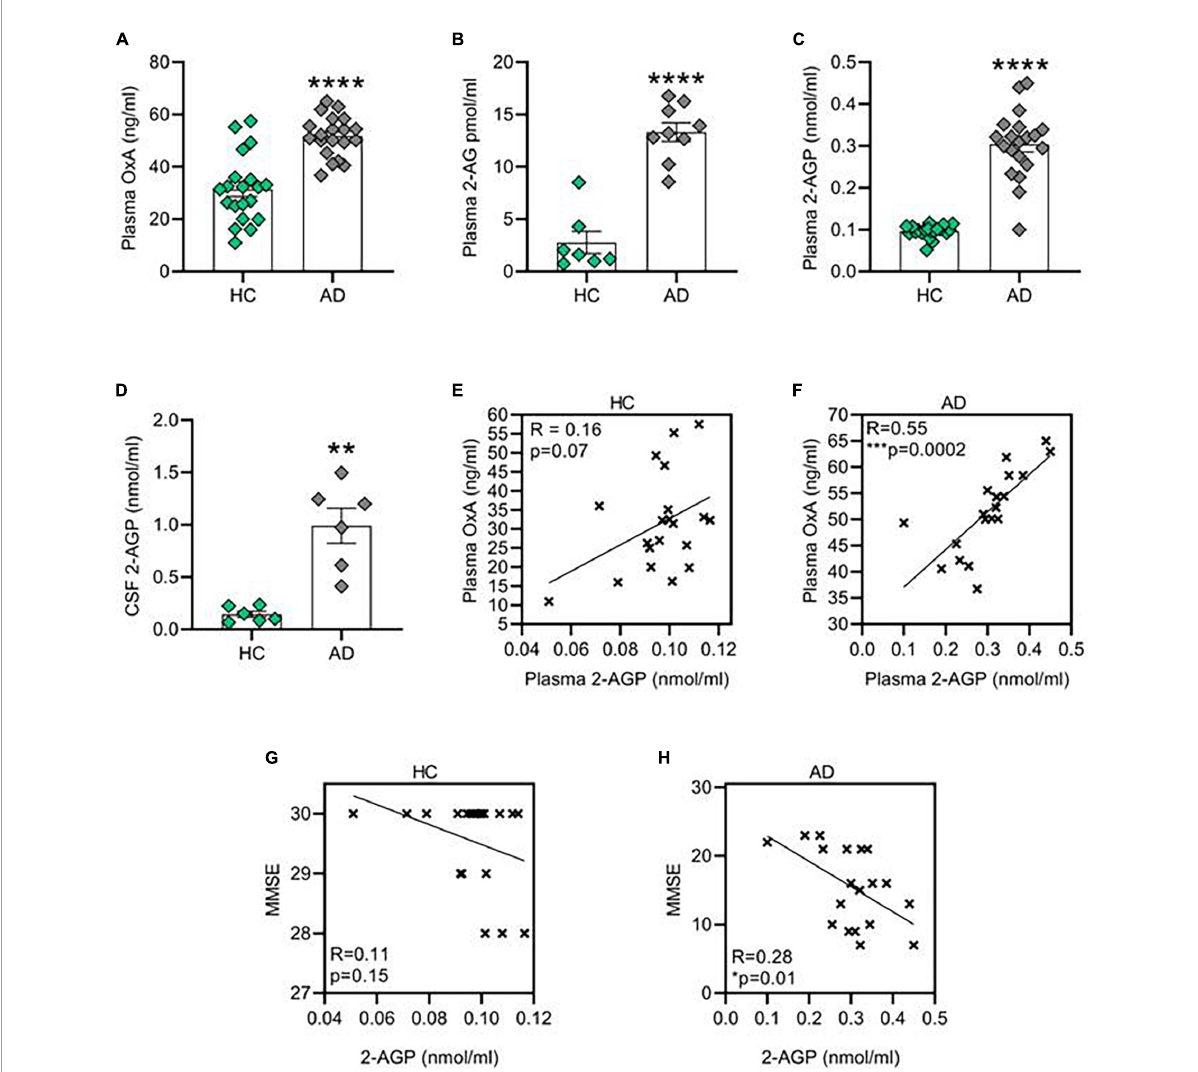
FIGURE1 Orexin-A, 2-AG and 2-AG derived 2-AGP are increased in patient affected by Alzheimer’s disease (AD). (A) Bar graph with mean ± SEM of OX-A levels in the plasma of healthy control and AD patients. HC (31.42 ± 2.8 ng/ml) vs. AD (51.71 ± 1.7 ng/ml), **** p < 0.0001 Unpaired two-tailed T test; n = 20 HC and 20 AD. (B) Bar graph with mean ± SEM of OX-A levels in the plasma of healthy HC and AD patients. HC (2.76 ± 1 pmol/ml) vs. AD (13.31 ± 0.8 pmol/ml), *** p < 0.001 two-tailed Mann–Whitney Test, U = 0, n = 7 HC and 9 AD. (C) Bar graph with mean ± SEM of 2-AGP levels in the plasma of healthy HC and AD patients. HC (0.09 ± 0.003 nmol/ml) vs. AD (0.3 ± 0.01 nmol/ml), **** p < 0.0001 two-tailed Mann–Whitney Test, U = 8.5, n = 20 control and n = 20 AD. (D) Bar graph with mean ± SEM of the 2-AGP levels in the cerebrospinal fluid of HC and AD patients. HC (0.14 ± 0.02 nmol/ml) vs. AD (0.99 ± 0.16 nmol/ml), ** p < 0.0001 Unpaired two-tailed T-test, n = 6 control and 6 AD. (E) Correlation between the OX-A and 2-AGP levels in the plasma of HC patients. Pearson’s correlation coefficient, p (two tailed) = 0.07. (F) Correlation between the OX-A and 2-AGP levels in plasma of AD patients. Pearson’s correlation coefficient, ***p (two tailed) < 0.001 . (G,H) Correlation between 2-AGP levels in the plasma of HC (G) or AD (H) subjects with the respective score obtained from each mini-mental state examination (MMSE). Pearson’s correlation coefficient p (two tailed) = 0.15 in HC and *p (two tailed) = 0.01 in AD